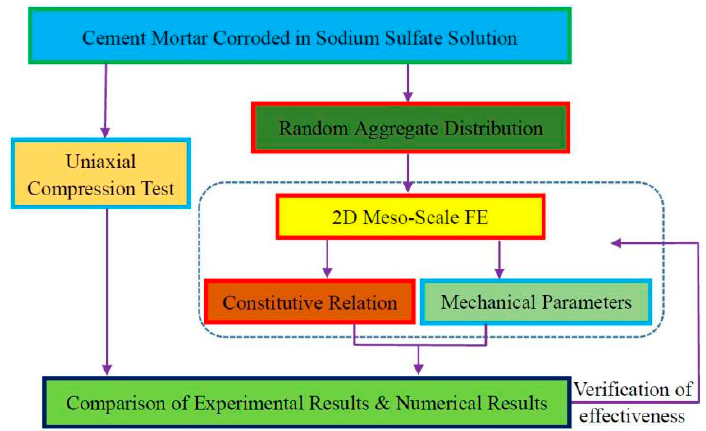
Figure 1. Roadmap of this paper.